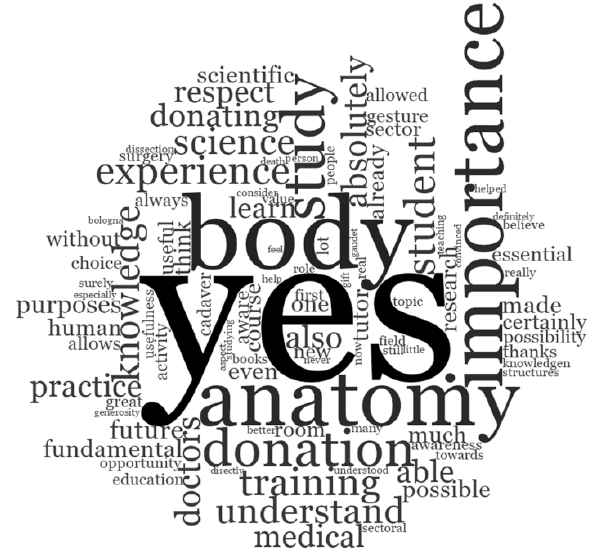
Figure 7. Word cloud of tutors’ responses to the open-ended question: “Do you feel that near-peer tutoring experience has/had positively influenced your perception towards body donation for medical education and scientific purposes?”.